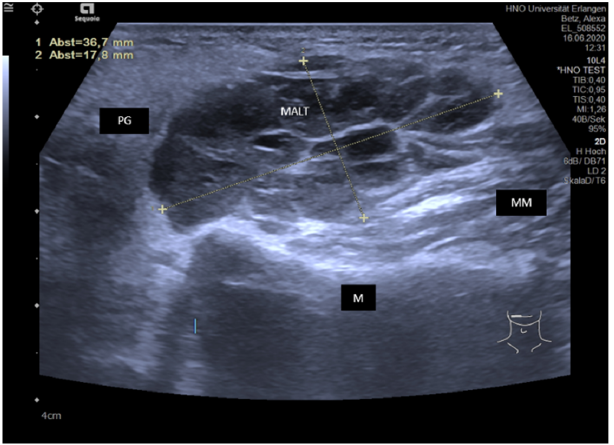
Figure 15. Histologically proven MALT lymphoma in a PG on the right side. A hypoechoic and lobulated, polycyclic space-occupying lesion with hyperechoic septal internal reflexes is depicted, measuring 36.7 × 17.8 mm. The lesion showed an increase in size during repeated follow-up investigations. Abbreviations: PG, parotid gland; M, mandible; MM, masseter muscle; MALT, MALT lymphoma.